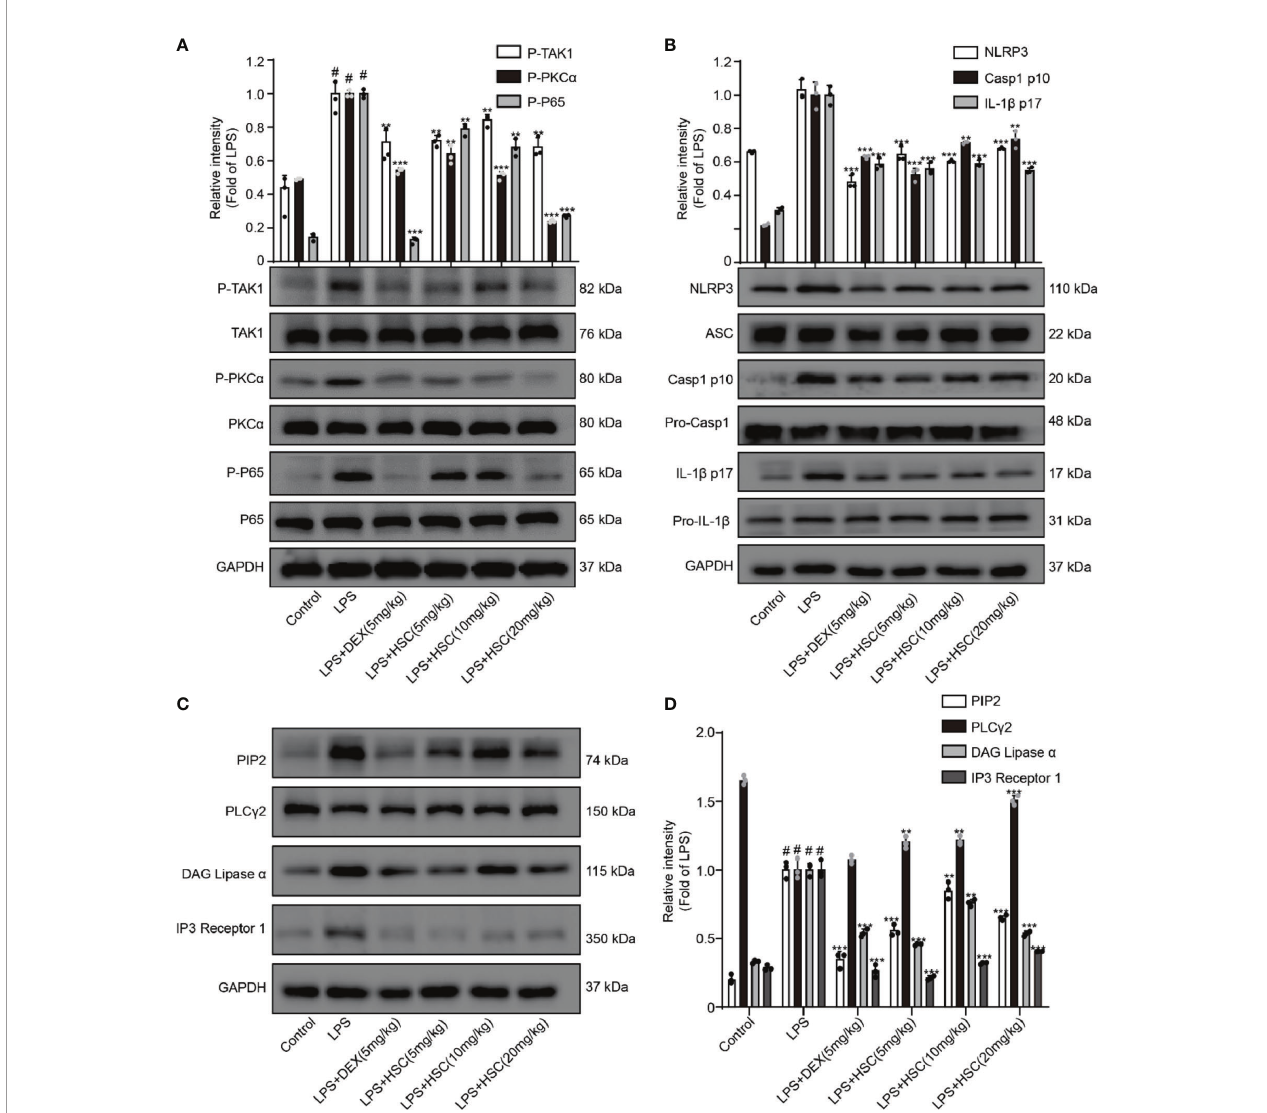
FIGURE 10 | HSC ameliorates ALI in mice by regulating the NF- k B/PIP2/NLRP3 pathway. The mice were treated with LPS (4mg/kg, i.t.). After LPS injection, mice were treated with HSC at 0 and 12 h, and the corresponding indexes were measured 24 h later. (A) Detection of TAK1/P-TAK1, PKC a /p-PKC a and p65/p-p65 protein expression in lung tissue by western blotting; (B) Detection of NLRP3/ASC/pro-caspa1/Caspa1 p10/IL-1 b /IL-1 b p17 protein expression in lung tissue; (C) PIP2/PLC g 2/DAG/IP3 protein expression in lung tissue by western blotting, and (D) statistical analysis of PIP2/PLC g 2/DAG/IP3 protein; ### P < 0.001 compared to control alone group; ** P < 0.01, and *** P < 0.001 versus the LPS group